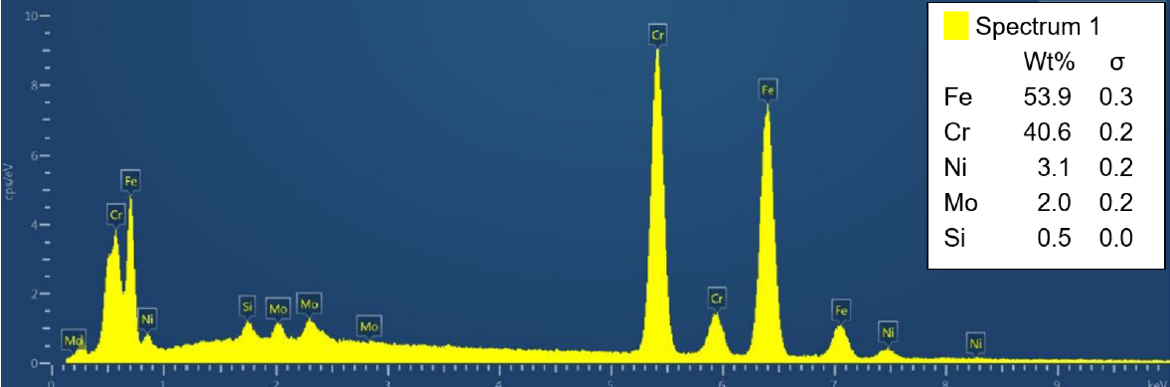
Figure 12. Indexed peaks of the EDXS point analysis of the sigma phase particle. For the basic observation, the electrolytic etching in the oxalic acid solution electro- lyte was fully sufficient. However, for the SEM observation, the oxalic acid etching com- pletely removed the sigma phase (see Figure 13).